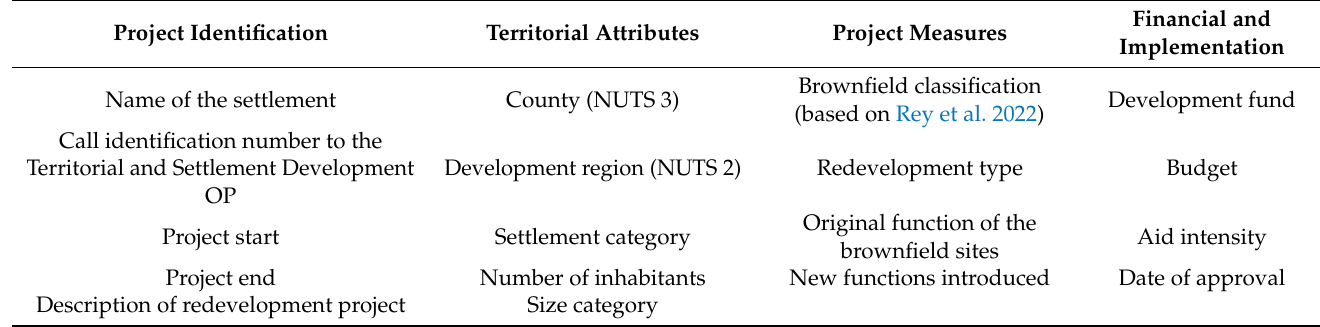
Table 2. Development projects’